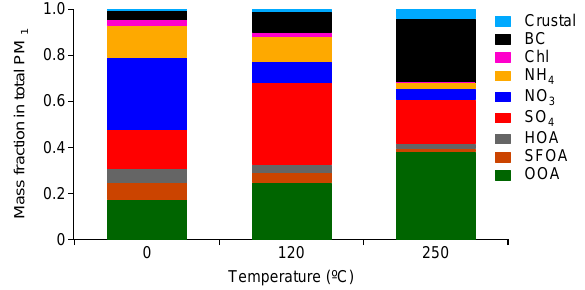
Figure 10. Mass fraction of PM 1 species for bypass line and TD line (i.e., 120 and 250 ◦ C). The mass fractions larger than 9% are labeled in the figure.